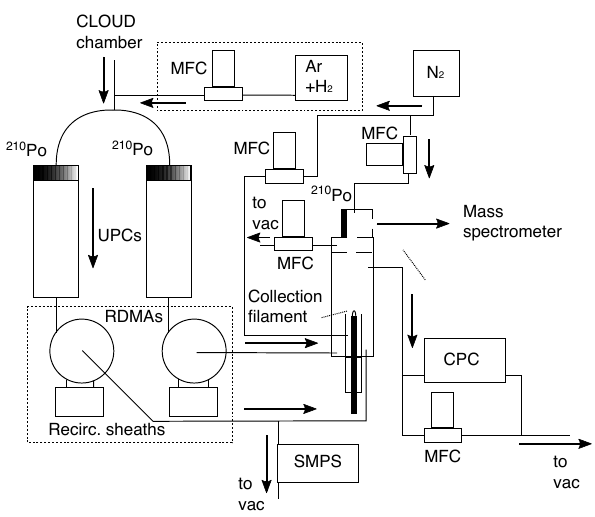
Figure 1. Schematic of the TDCIMS instrument as deployed at CLOUD7. Dashed boxes show components that were not always connected. Particles from sampled chamber air were negatively charged in the UPCs (unipolar chargers), optionally size-selected by radial differential mobility analyzers (RDMAs), and electrostat- ically precipitated onto a Pt collection filament (shown here in col- lection position) held at + 4kV over a period of 15 or 30min. The filament was then translated vertically into the ion source of a time- of-flight (TOF) mass spectrometer and the sampled material was thermally desorbed and/or decomposed by a temperature ramp of the wire at atmospheric pressure in a dry N 2 environment. The resulting compounds were ionized and passed into the TOF via electrostatic and octopole ion guides. CPC: condensation particle counter. MFC: mass flow controller. Vacuum pumps and vacuum lines have been omitted from the